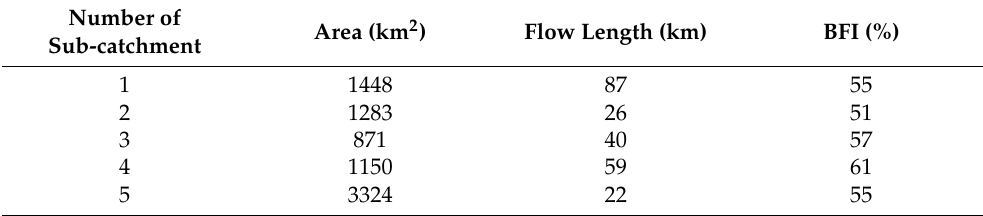
Table 2. Area (m 2 ), flow length (km) and baseflow index (BFI) (baseflow/total streamflow) for each of the five individual sub-catchments. Sub-catchments are numbered systematically upstream-to-